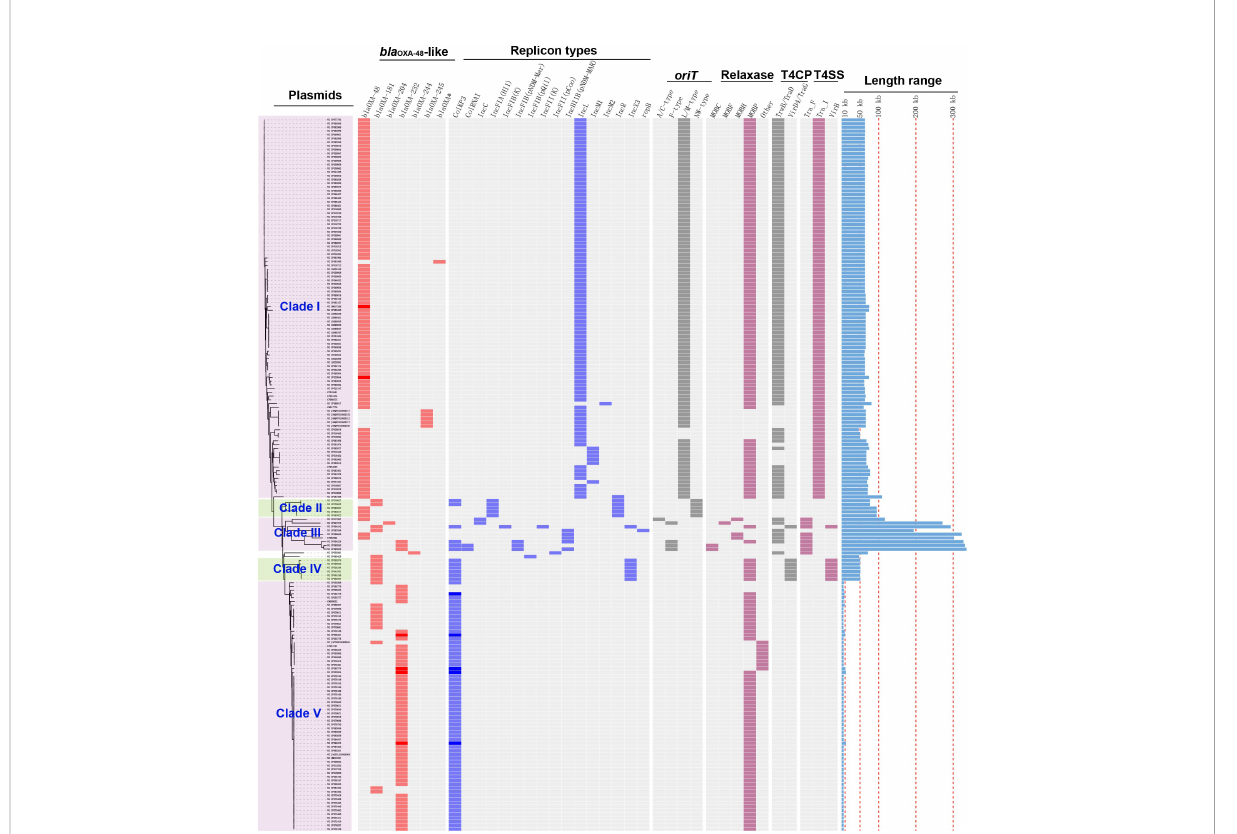
FIGURE 2 Details of variants of bla OXA-48 -like genes, replicon types, conjugative transfer regions, and length distribution of the 191 bla OXA-48 -like-harboring plasmids of K. pneumoniae . The four categories of information present in this fi gure include the phylogenetic tree, variants of bla OXA-48 -like, replicon types, conjugative transfer regions ( oriT , relaxase, T4CP, and T4SS), and length distribution of the 191 bla OXA-48 -like-harboring plasmids of K. pneumoniae